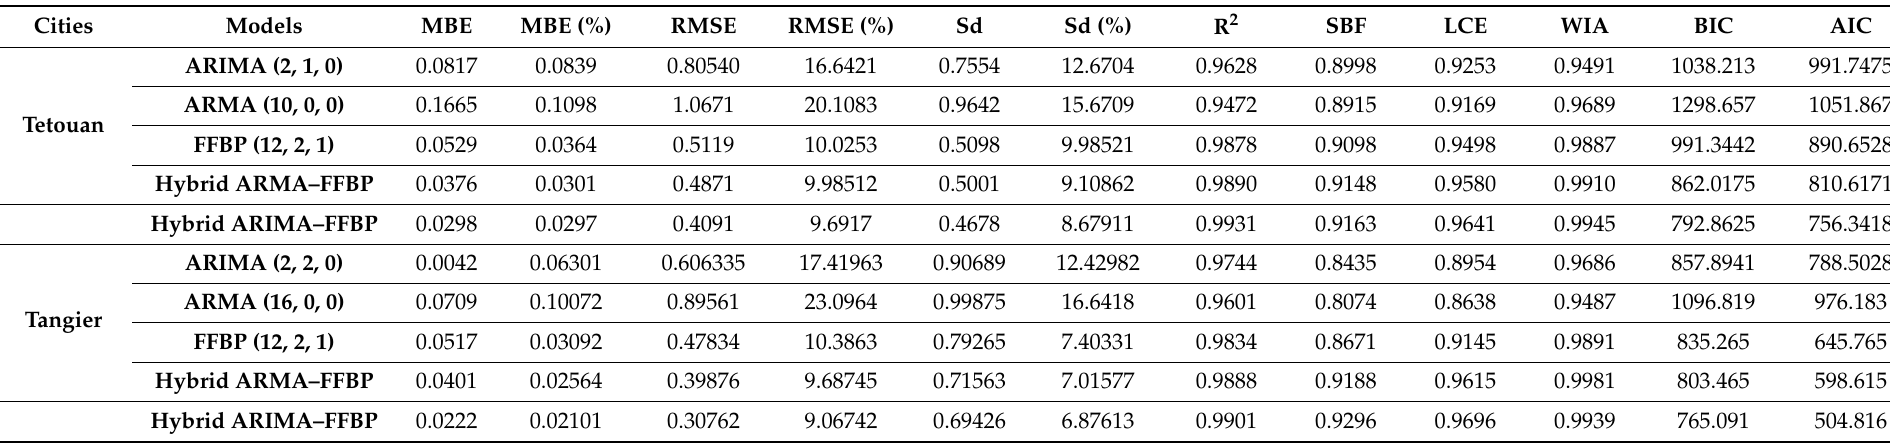
Table 6. Statistical results of the FFBP, ARMA, ARIMA, and hybrid network